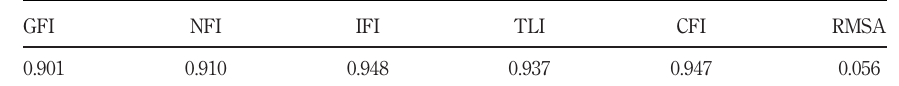
Table I. Goodness of fi t of structural model (single-brand